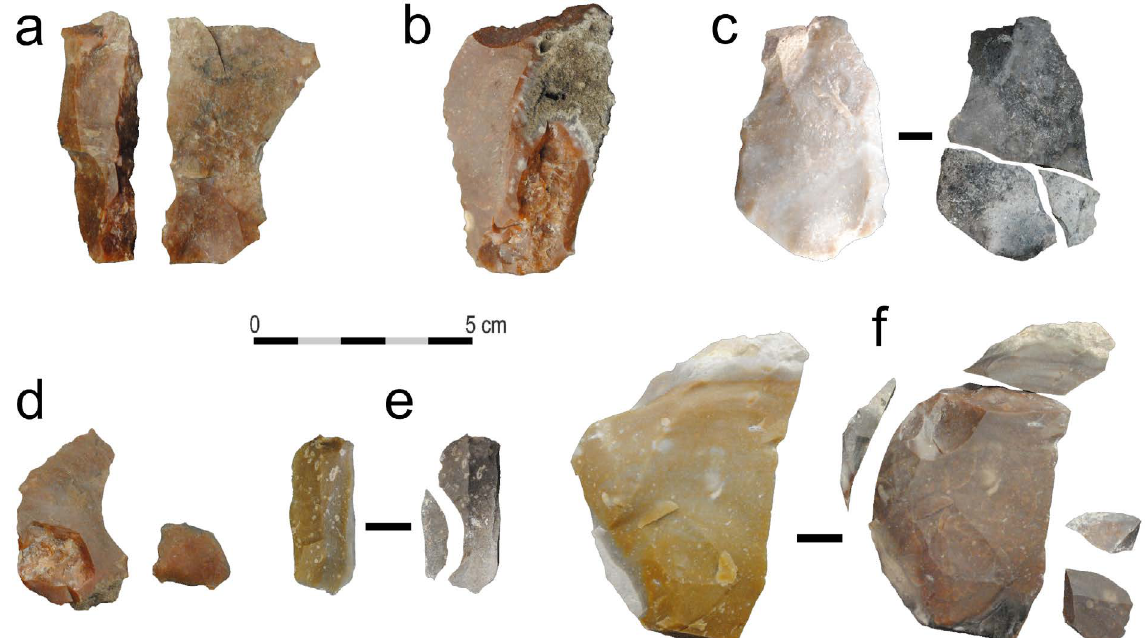
Figure 4. Samples of some heat alterations analyzed along the experimental record: a) longitudinal fracture; b and d) thermal bubble or pot-lids; c and f) marginal and transversal